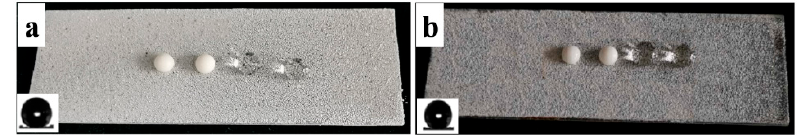
Figure 11. Photographs of yogurt and water droplets ( a ) on a coated glass surface and ( b ) after 200 days.